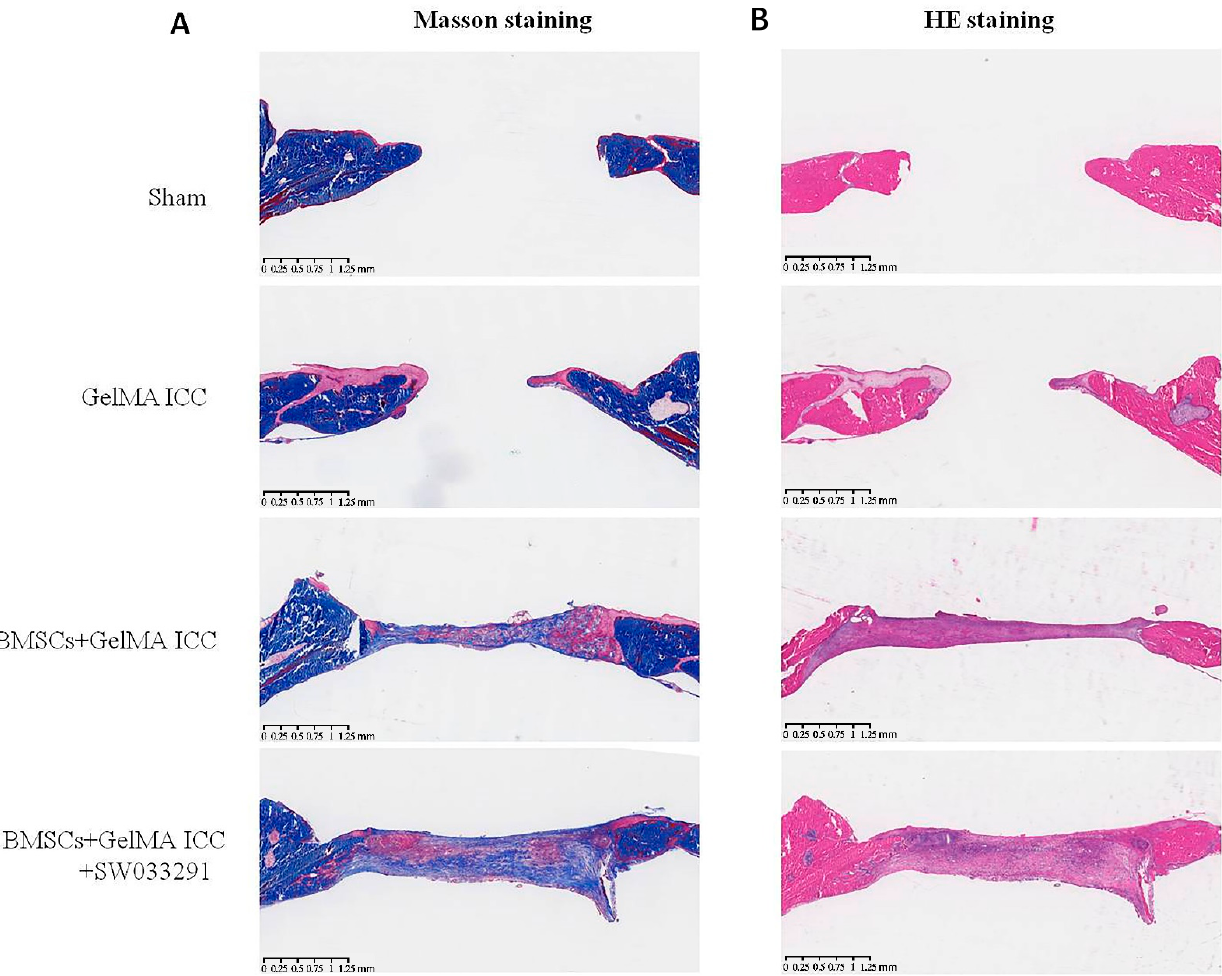
Figure 7. Histological staining for bone formation at the calvarial region in different groups. ( A ) Masson staining and ( B ) H&E staining for new bone formation.